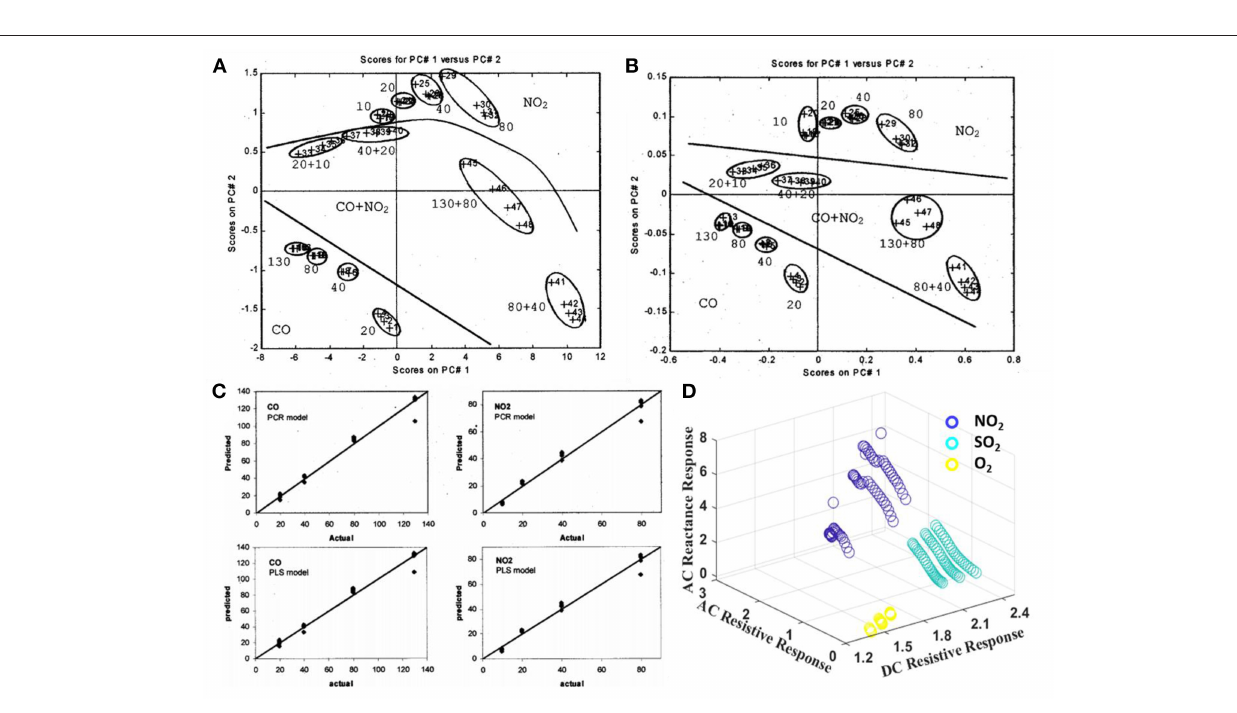
FIGURE 14 | PCA plots of sensor response processed by the (A) FFT and (B) DWT method. (C) Predicted results vs. actual concentrations of CO and NO 2 given by PCR and PLS models. Reprinted with permission from Llobet et al. (2001), copyright 2001 IEEE. (D) Preliminary 3D figure of correlated response dataset of impedance-metric and resistive modes for NO 2 , O 2 , and SO 2